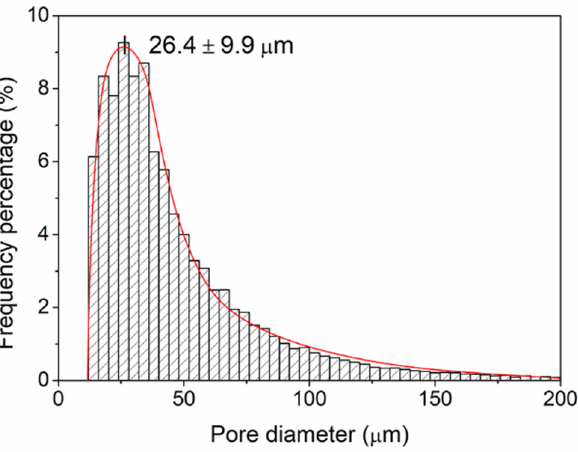
Figure 10. Pore size distribution of the leached scaffold determined via microCT analysis.